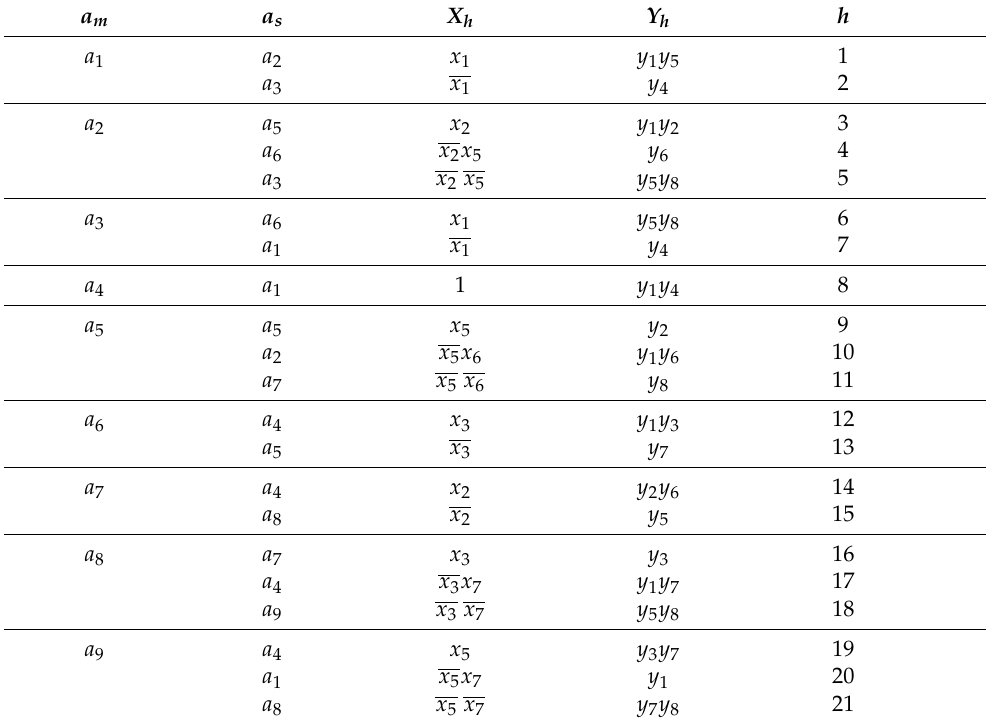
Table 1. State transition table of Mealy FSM S 1